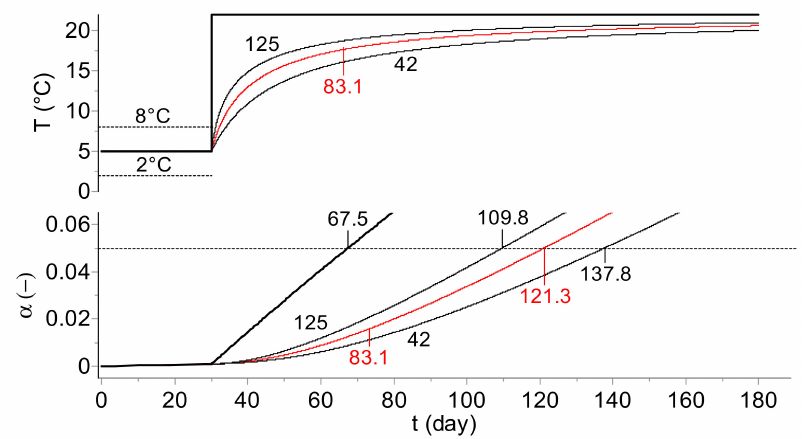
Figure 6. Model vaccine: Simulation of the long-term prediction of the change of virus infectivity (infectious titer) during the temperature excursion from 5 to 22 ◦ C (TOR procedure). Top plot: time dependence of the real (bold) and MKT temperatures, bottom plot: the degree of infectious titer for the real (bold) and MKT temperatures. The mean kinetic temperatures were calculated for three activation energy values (marked on the curves in kJ · mol − 1 ). Note that application of the MKT leads to the overestimation of the shelf life: the value of 5% of degradation is reached after 67.5 days if following the real temperature, whereas according to the MKT, depending on the assumed activation energy, this loss of infectious titer is reached after ca. 110, 121, and 138 days for E = 42, 83.1, and 125 kJ · mol − 1 , respectively.